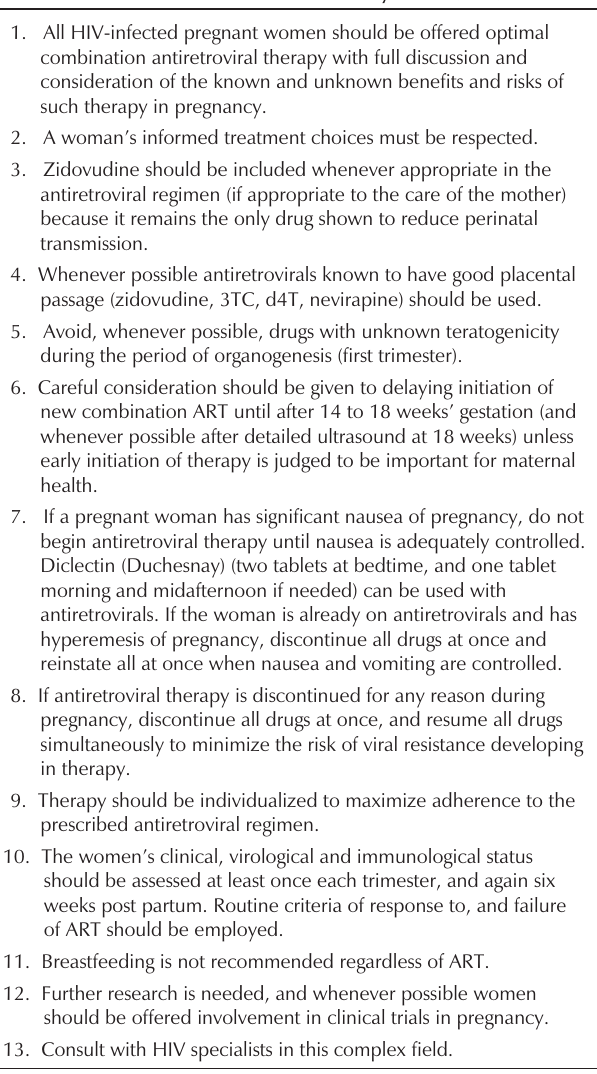
Therapeutic strategies for the treatment of pregnant women infected with human immunodeficiency virus